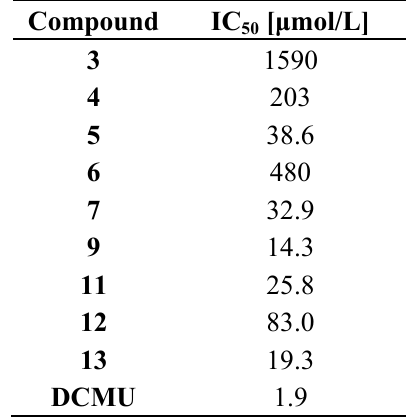
values [ μ mol/L] of tested compounds related to PET inhibition in spinach Table 4. IC 50 chloroplasts in comparison with 3-(3,4-dichlorophenyl)-1,1-dimethylurea (DCMU) standard.